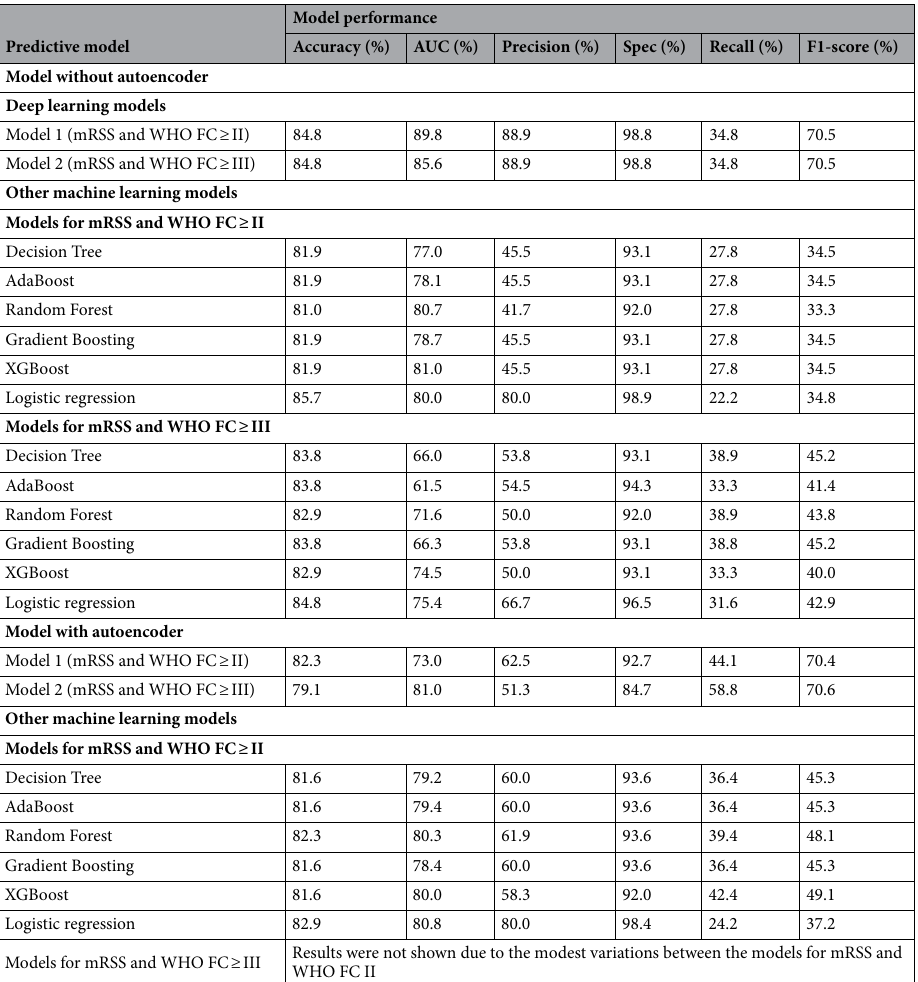
Table 3. Performance of the different algorithms. AUC Area under the receiver operating characteristics (ROC), mRSS modified Rodnan skin score, WHO FC World Health Organization functional class, Spec. Specificity, precision—positive predictive value, recall—sensitivity, CV cross-validation.